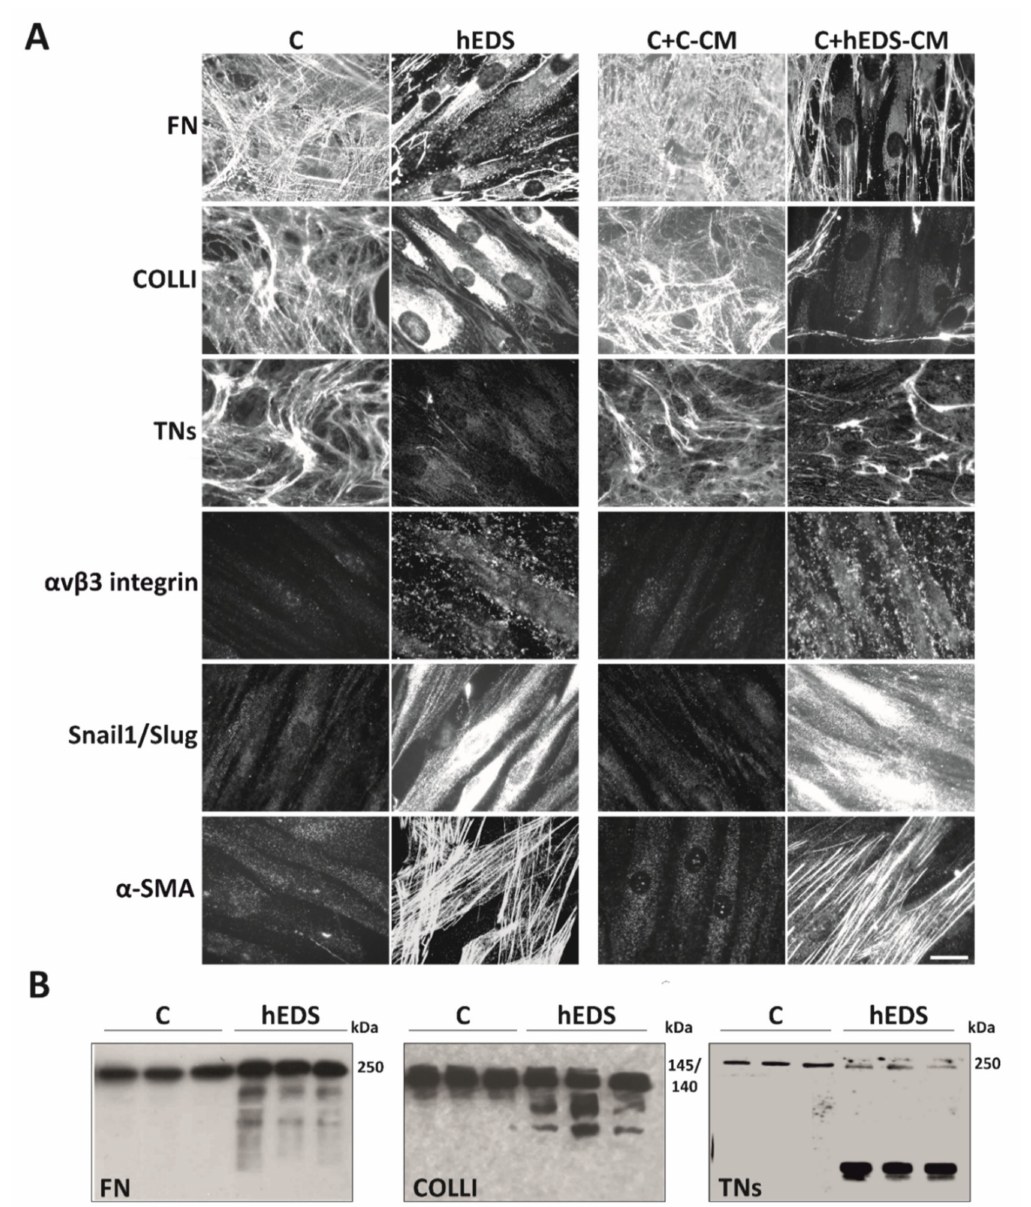
Figure 1. Proteolytic and differentiation potential of hEDS-CM. ( A ) On the left: IF analyses of FN-, COLLI, and TNs-ECM organization, α v β 3 integrin and Snail1/Slug transcription factor expression, and α -SMA cytoskeleton assembly in control (C) and patient (hEDS) dermal fibroblasts grown for 10 days (6 days for TNs and COLLI) in complete MEM. The images are representative of 6 different cell strains for each group. On the right: IF analyses of control dermal fibroblasts grown for 10 days (6 days for TNs and COLLI) in the presence of a pool of CM recovered from six 72 h-grown control (C + C-CM) and six hEDS (C + hEDS-CM) cell strains. Images are representative of three independent experiments. Scale bar: 12 µ m. ( B ) WB of 80 µ g of proteins recovered from the above-mentioned pooled control and hEDS-CM immunoreacted with anti-human FN Ab, goat anti-human COLLI Ab, and with a mAb recognizing all human isoforms of TNs. WB data represent three technical replicates for each